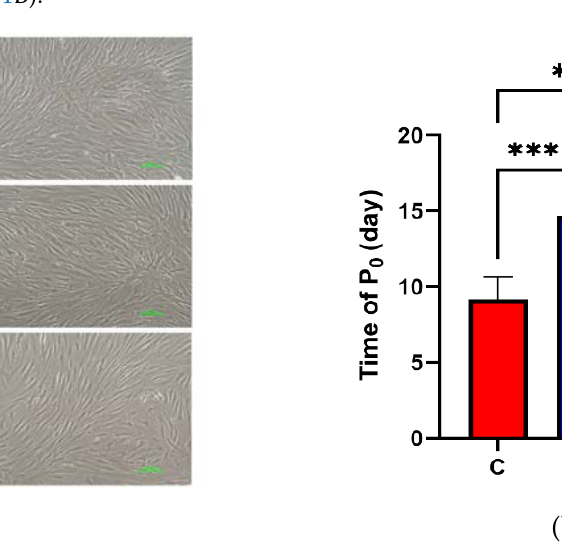
Figure 1. Morphology of dental pulp cells in different preservation strategy groups. ( A ) Morphology of dental pulp tissue and cells at the primary and the third generation. I–III: C group—Primary cells emerged from tissue blocks ( × 40; × 100) and the cells from the third generation after passage ( × 100). IV–VI: T1 group—Primary cells emerged from tissue blocks ( × 40; × 100) and the cells from the third generation after passage ( × 100). VI–IX: T2 group—Primary cells emerged from tissue blocks ( × 40; × 100) and the cells from the third generation after passage ( × 100). ( B ) The first appearance time of dental pulp cells in different groups: The first appearance time of dental pulp cells in